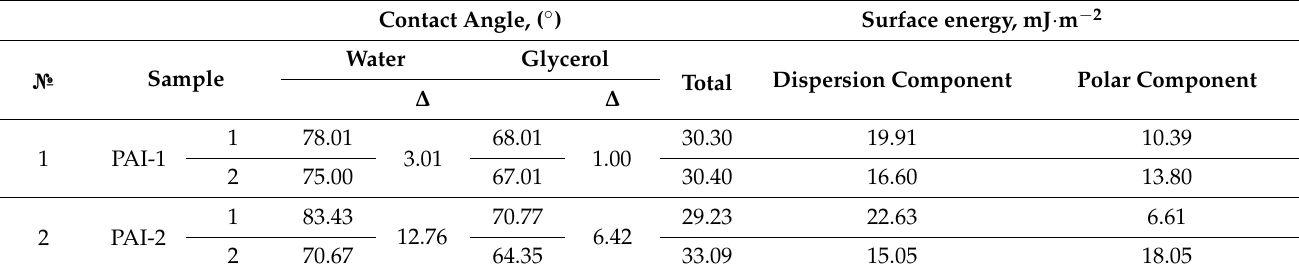
Table 3. Surface characteristics of dense films (1—upper surface, 2—lower surface). Contact Angle, (°)